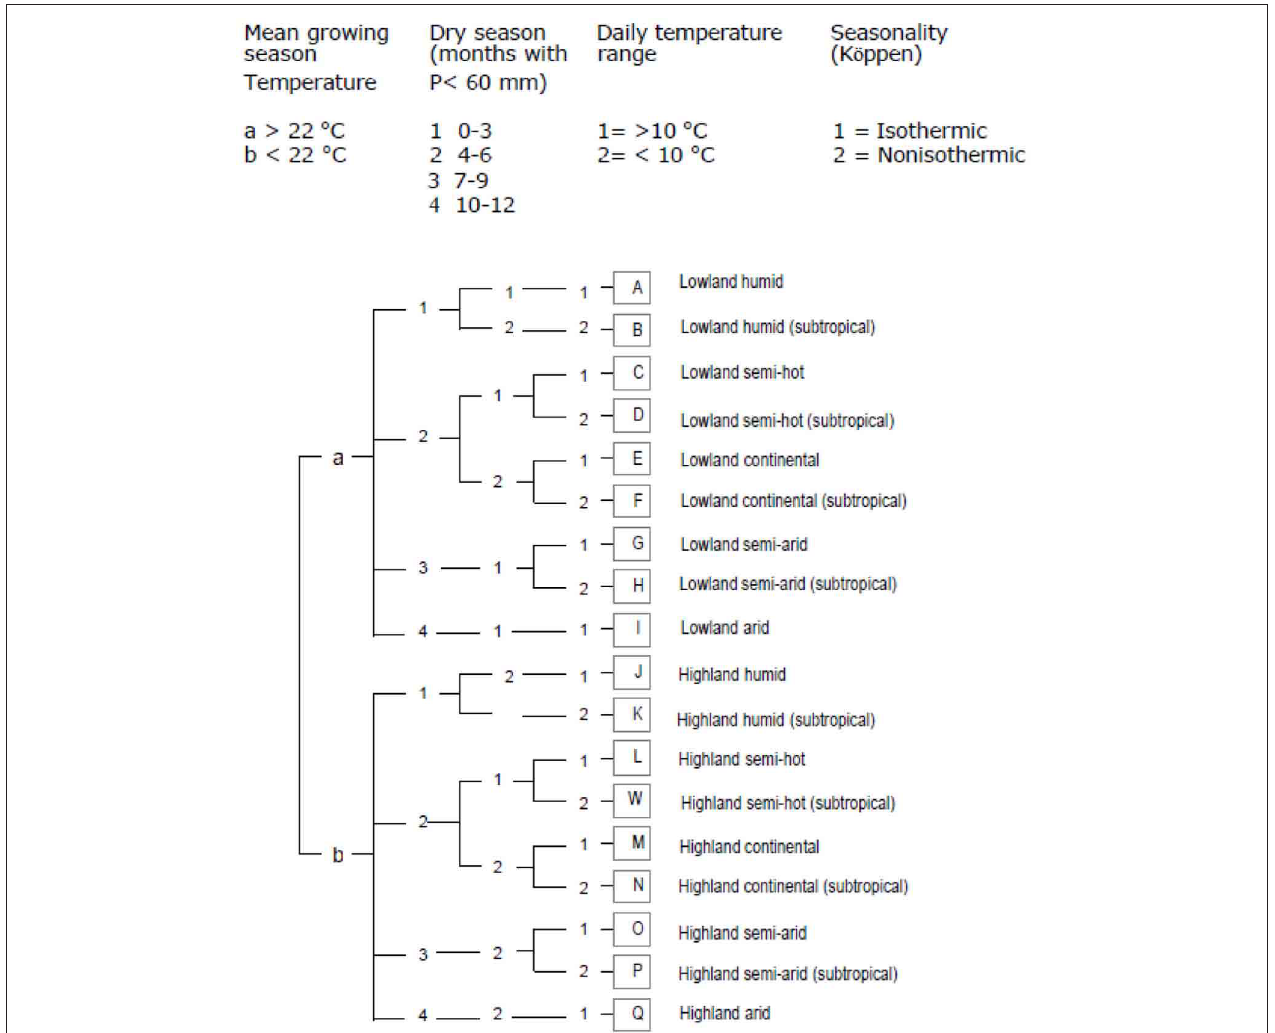
FIGURE 5 | Diagram showing the classification scheme for CIAT’s cassava agro-ecology map (CIAT, 2003).